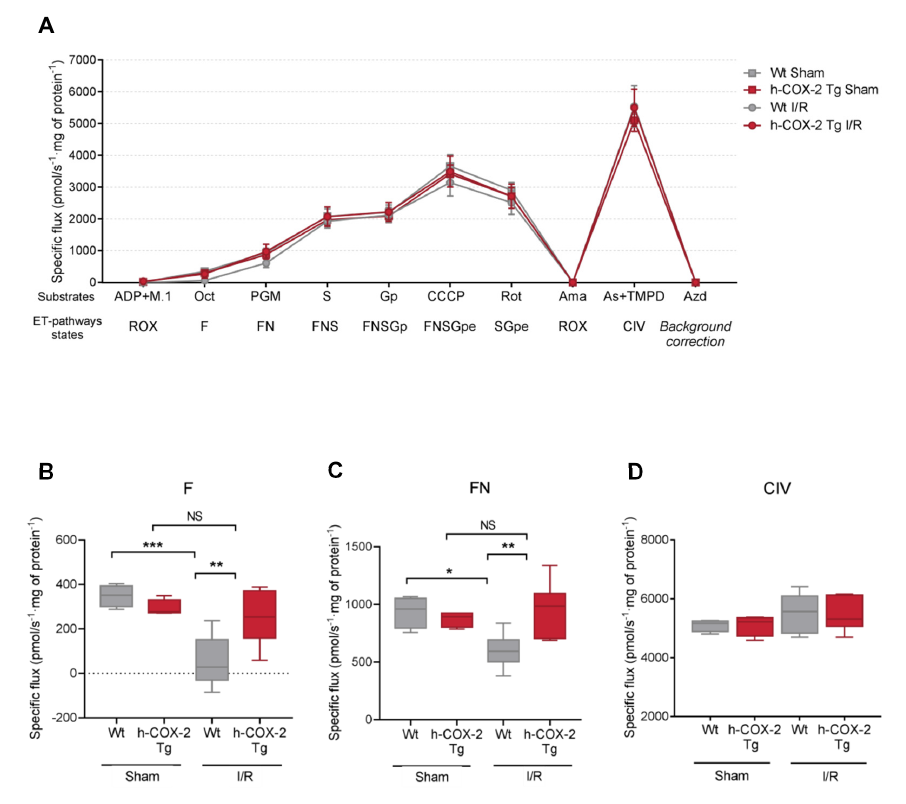
Figure 1. High-resolution respirometry of liver-derived mitochondria after Sham or I/R surgery of Wt and h-COX-2 Tg mice. ( A ) Complete profile of the SUIT2 protocol, with the different substrates administrated (ADP, malate (M), octanoyl-carnitine (Oct), pyruvate (P), malate, glutamate (G), succinate (S), glycerol-phosphate (Gp), CCCP and rotenone (Rot), and the ET-pathways states (ROX, residual oxygen consumption; F, F-junction pathway; N, N-junction pathway; S, succinate pathway; Gp, glycerol-phosphate pathway; e, uncoupled state, maximal respiration). After the addition of complex I inhibitor rotenone, the system was inhibited by the addition of complex III inhibitor antimycin A (Ama), and complex IV was fed with ascorbate (As) and TMPD. Later, all the system was inhibited by sodium azide and complex IV was measured after chemical background calibration. Specific flow is expressed as pmoL/s · mg of protein of states F ( B ), FN ( C ) and CIV ( D ) in detail. Box plots of 4–9 independent measures. Statistical test: one-way ANOVA, followed by Tukey’s posthoc